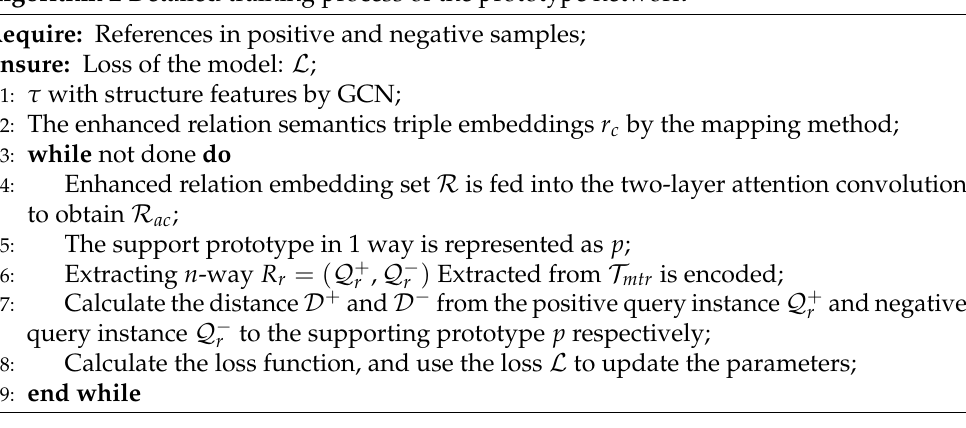
Algorithm 2 Detailed training process of the prototype network